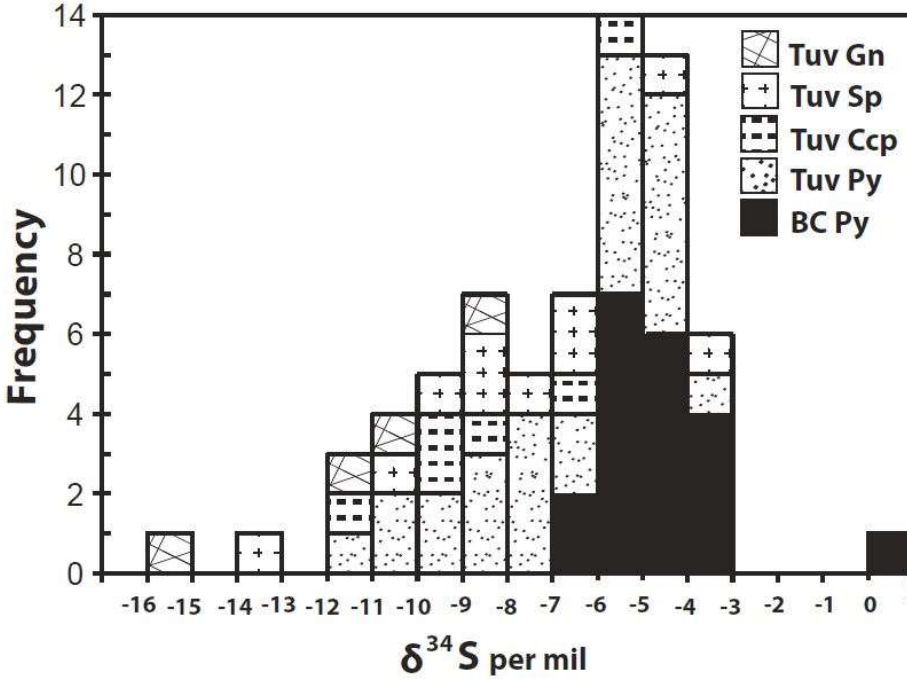
Figure 13. Histogram of δ 34 S compositions of pyrite from the Banana Creek (BC Py; this study) and galena (Gn), sphalerite (Sp), chalcopyrite (Ccp), and pyrite (Py) for epithermal veins from the Tuvatu prospect (data from [10]).